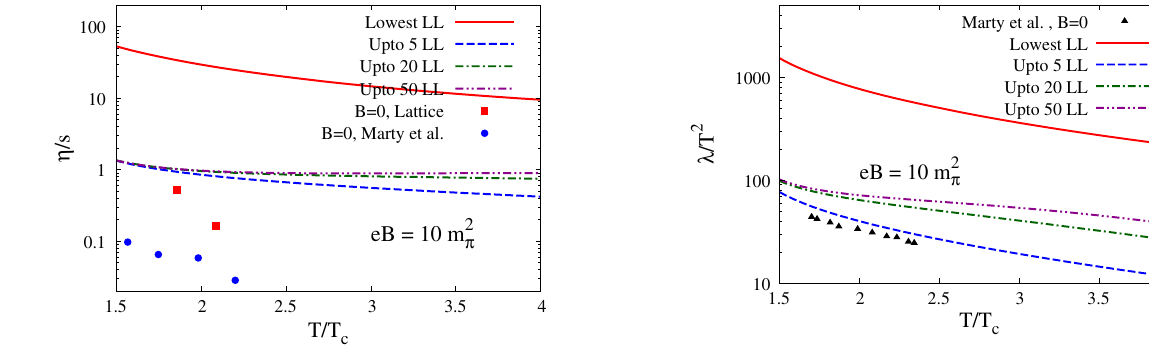
Fig. 3 The effects of HLLs on the temperature behaviour of η/ s at | eB |= 10 m 2 π . Lattice data [43] and result of Marty et al. [47] for